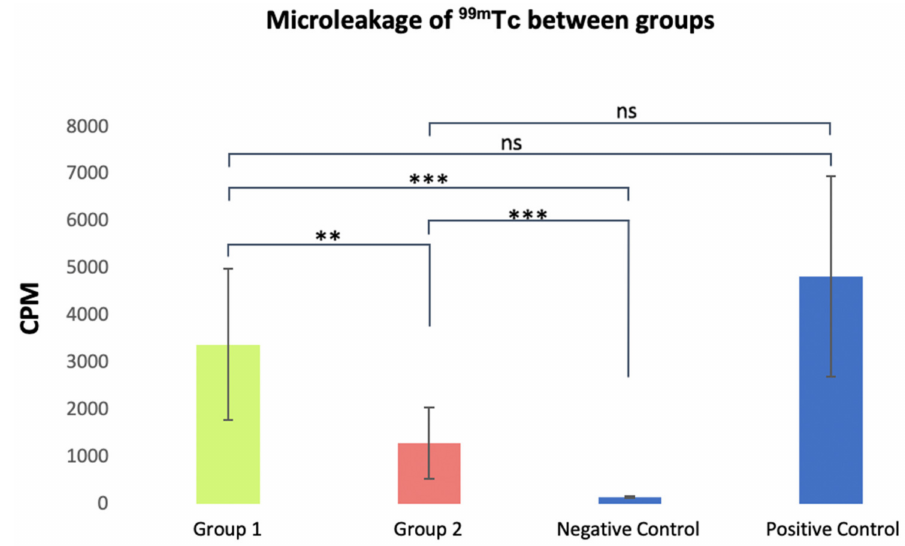
Figure 2. Visual representation of mean values and standard deviation of total counts in each group and significance level between groups: ** p < 0.01; *** p < 0.001; ns—meaningless. Group 1: Surefill One™; Group 2: Spectra™ ST HV composite; CPM: counts per